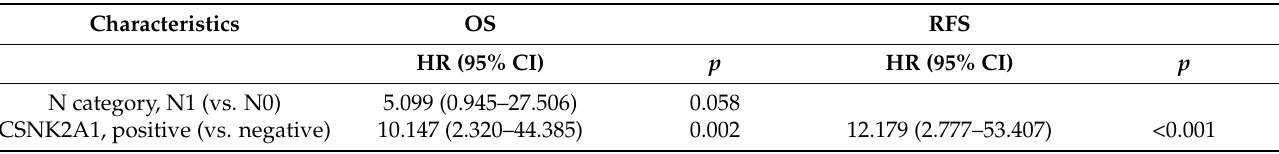
Table 3. Multivariate Cox proportional hazards regression analysis for the survival of 37 osteosarcoma patients. Characteristics